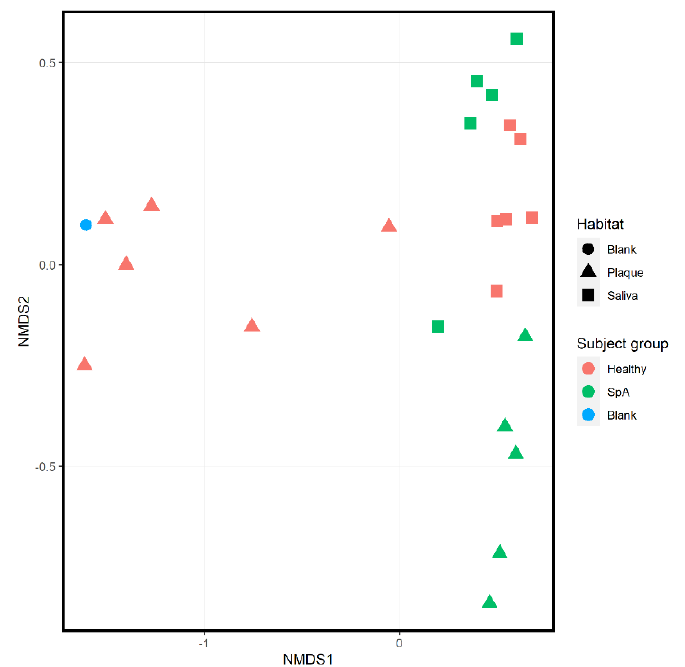
Figure 3. Ordination analysis of sub-gingival and salivary samples obtained from healthy control subjects and children with Spondyloarthritis. A negative control (blank) is included as well. The shape of the dot indicates the habitat (circle, blank specimen; triangle, plaque; square, saliva), while the color of the specimen indicates the subject group (blue, blank specimen; green, Spondyloarthritis; red, Healthy controls).